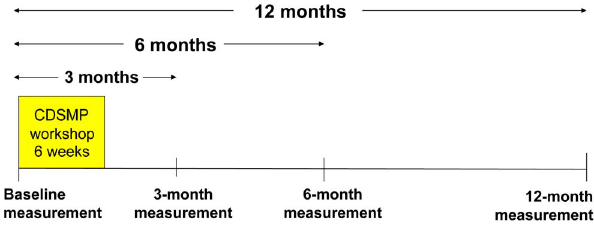
Figure 1. Timing of data collection. Data were collected once before the educational program began (baseline), and then three more times over the following year.